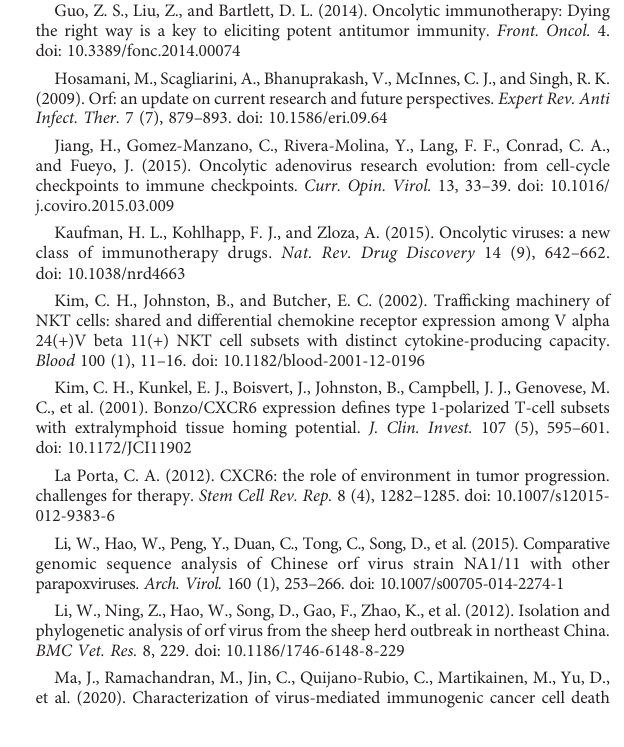
SUPPLEMENTARY FIGURE 1 ORFV NA1/11 infection causes varying levels of lung cancer cell death in vitro . (A) The indicated lung cancer cells were infected with, or without, ORFV NA1/11 at an MOI of 5 for 48 hours. Their viability was measured by WST-8 assays. Data are expressed as the relative percentages of cell viability in each group of cells from three separate experiments. The cell viability in the control cells without virus infection was designated as 100%. (B) The A549 cell were infected with ORFV NA1/11-GFP at an MOI of 5. The images were obtained 48 hpi. SUPPLEMENTARY FIGURE 2 Intratumoral injection with ORFV NA1/11 does not change the body weights and many tissue (A, B) Longitudinal measurements of body weights in both groups of tumor-bearing mice. (C) Histological analysis of the morphology of the indicated tissues after H&E staining. Data are representativeimagesor expressed asthemean±SDofeachgroup (n=6) of mice. SUPPLEMENTARY FIGURE 3 Flow cytometry gating strategies. All cells in each group were gated on single mononuclear cells and on living cells. Subsequently, the living CD11c + DCs, CD4 T cells, CD8 T cells were gated and the levels of CD80, CD86 and granzyme B expression were analyzed. SUPPLEMENTARY FIGURE 4 A diagram of experimental design: LLC cells were infected with ORFV NA1/11 for 2 h and washed. DCs were overlaid onto infected tumor cells and cultured in transwell